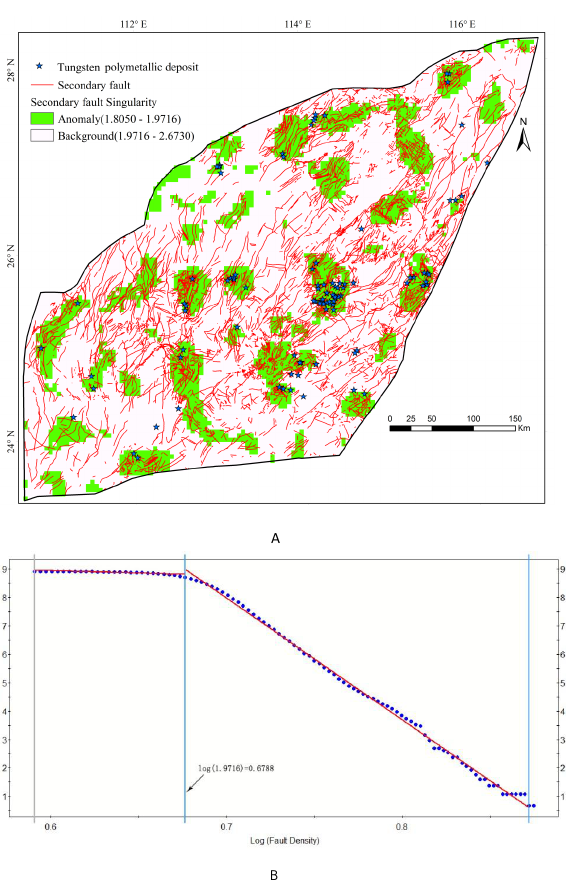
Fig.4. (A) Map showing the secondary faults density singularity, and (B) Log–log plots for the 431 secondary faults. 432 Fig. 4. (A) Map showing the secondary fault density singularity, and (B) Log-log plots for the secondary faults.